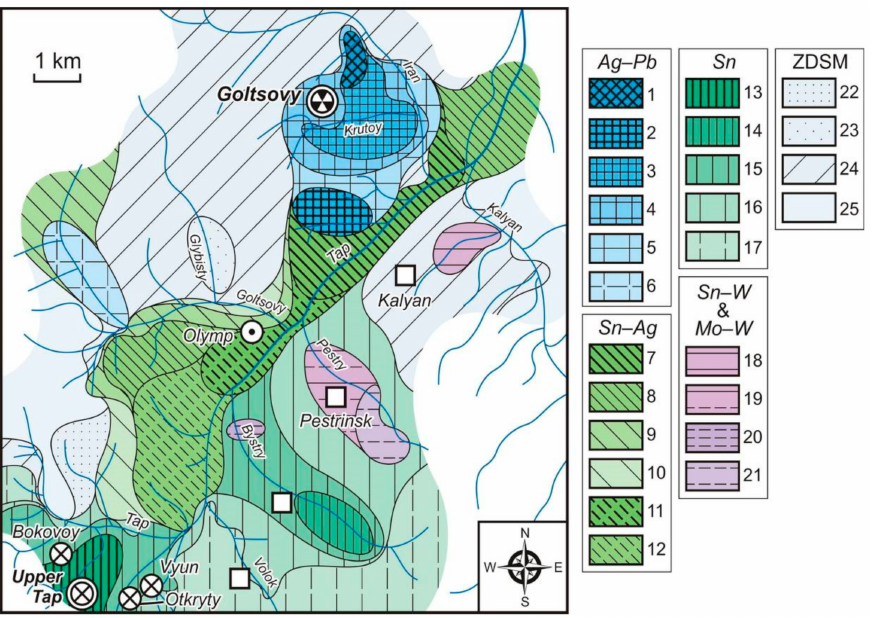
Figure 9. The Pestrinsk SBS (fragment). Polyelement AGCFs identified through SSs (survey at a 1:50,000 scale). 1–24—geochemical associations of elements (see Table 3): 1–6— Ag – Pb ; 7–12— Sn – Ag ; 13–17— Sn ; 18–21— Sn – W and Mo – W ; and 22–25—variable composition in